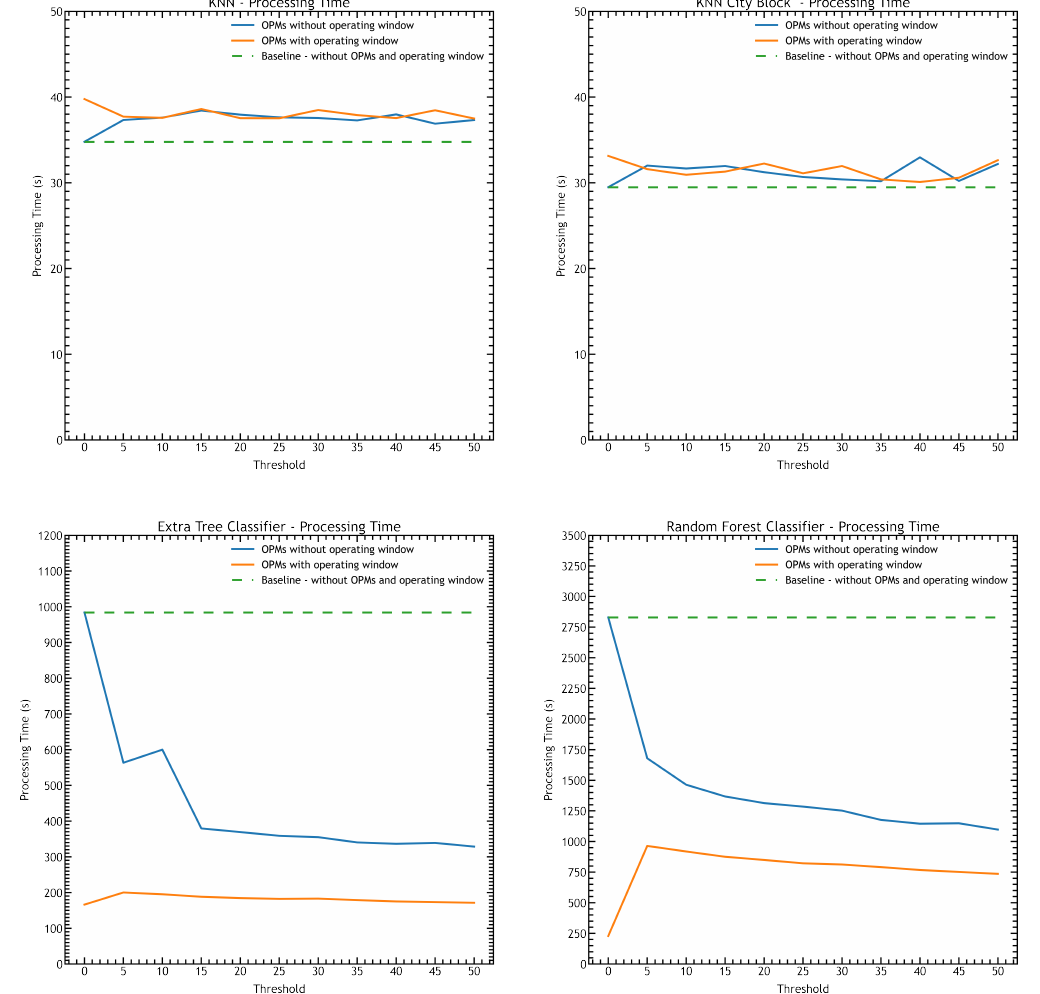
Figure 5. Processing time variation of the trained algorithms.